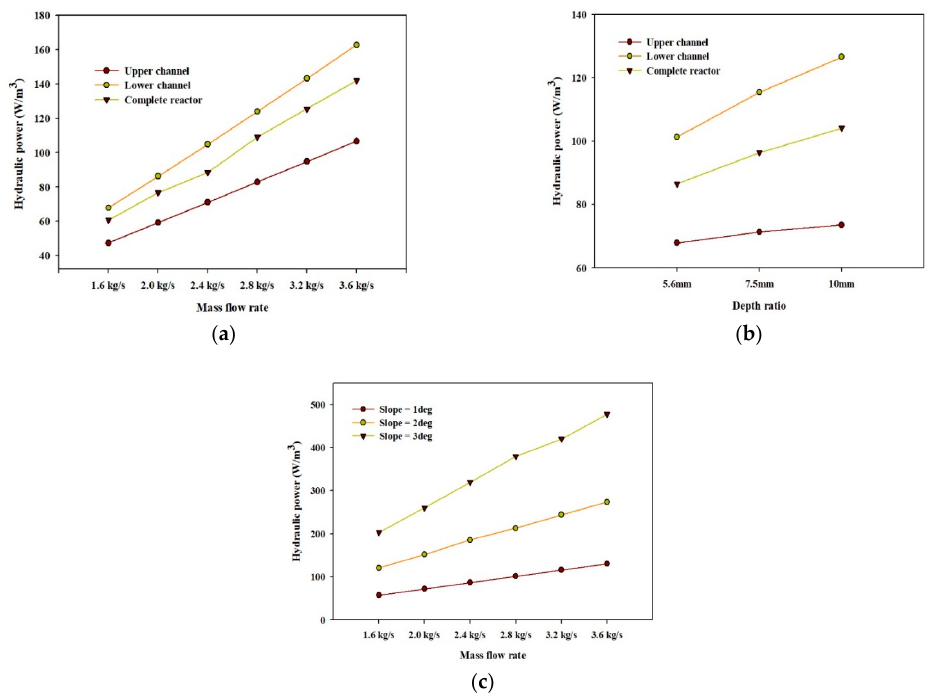
Figure 8. Hydraulic power consumption ( a ) for different mass flow rates at a water depth of 5.6 mm and slope angle of 1°, ( b ) for various water depths at a mass flow rate of 2.4 kg/s and slope angle of 1°, and ( c ) for the complete reactor with the variation in mass flow rate and slope angle.